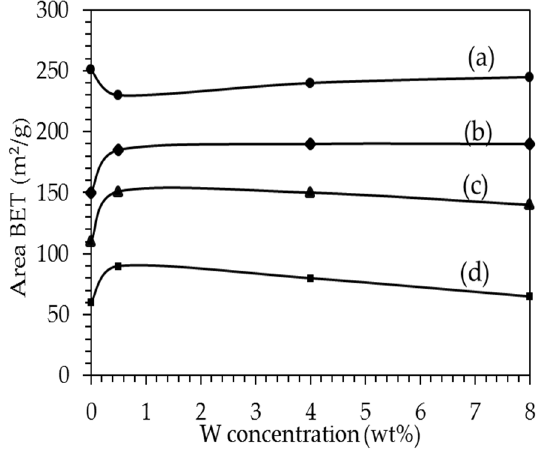
Figure A1. BET area against W concentration (in wt%W) named Al 2 O 3 –WOx, when the calcination temperature increased: ( a ) 500 °C; ( b ) 650 °C; ( c ) 800 °C; ( d ) 950 °C for 6 h.